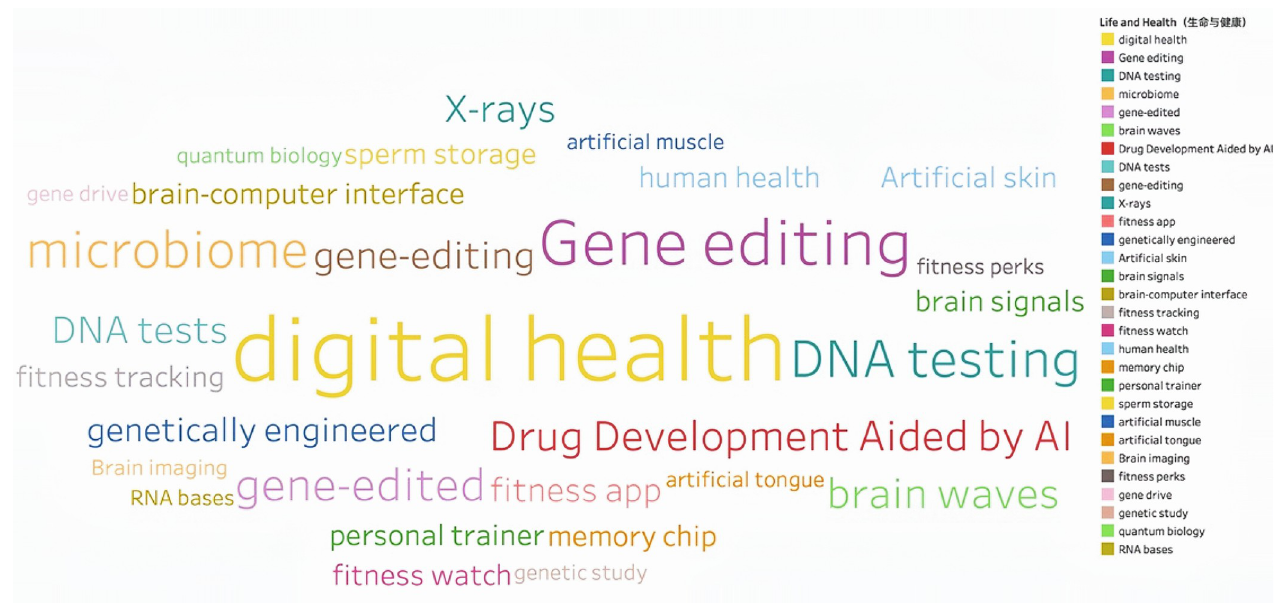
Fig 3. Word cloud diagram in the field of Life and Health.